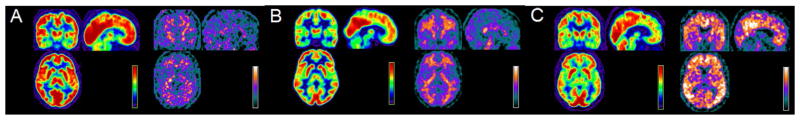
Three representative cases: (A) 50 y/o FH− with FDG−/PiB− scans; (B) 52 y/o FHm with FDG+/PiB− scans; (C) 65 y/o FHm with FDG+/PiB+ scans.